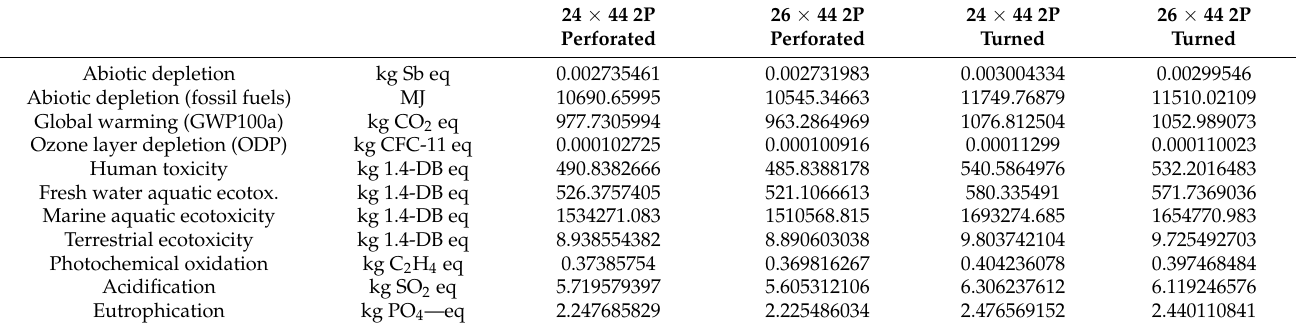
Table 5. Global impact for each geometry and production methodology, by impact